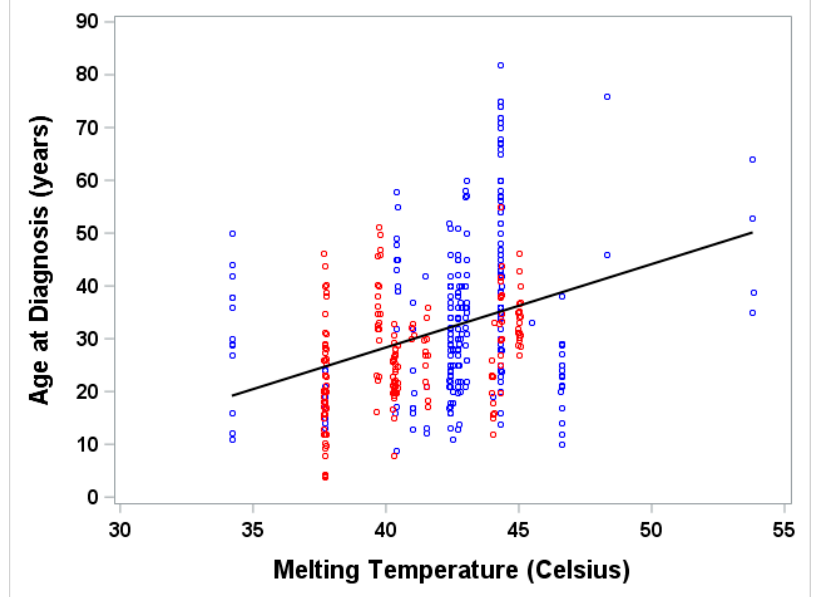
Figure 3. Age at diagnosis vs melting temperature, using randomly generated data points according to literature with summary statistics. Age for those with known individual ages (blue) and those with unknown individual ages (red) whose ages were imputed by a value randomly drawn from a Gaussian distribution with known mean age and standard deviation, SD, (SD was calculated as [maximum age–minimum age]/4 if SD was not given) and truncated by the given range. Pearson correlation coefficient between age of diagnosis and melting temperature is 0.34489. Linear regression of age of diagnosis (Age) on melting temperature (MT) is Age = -34.82 + 1.58×MT ( p < 0.0001); R-squared = 0.119; n = 458.